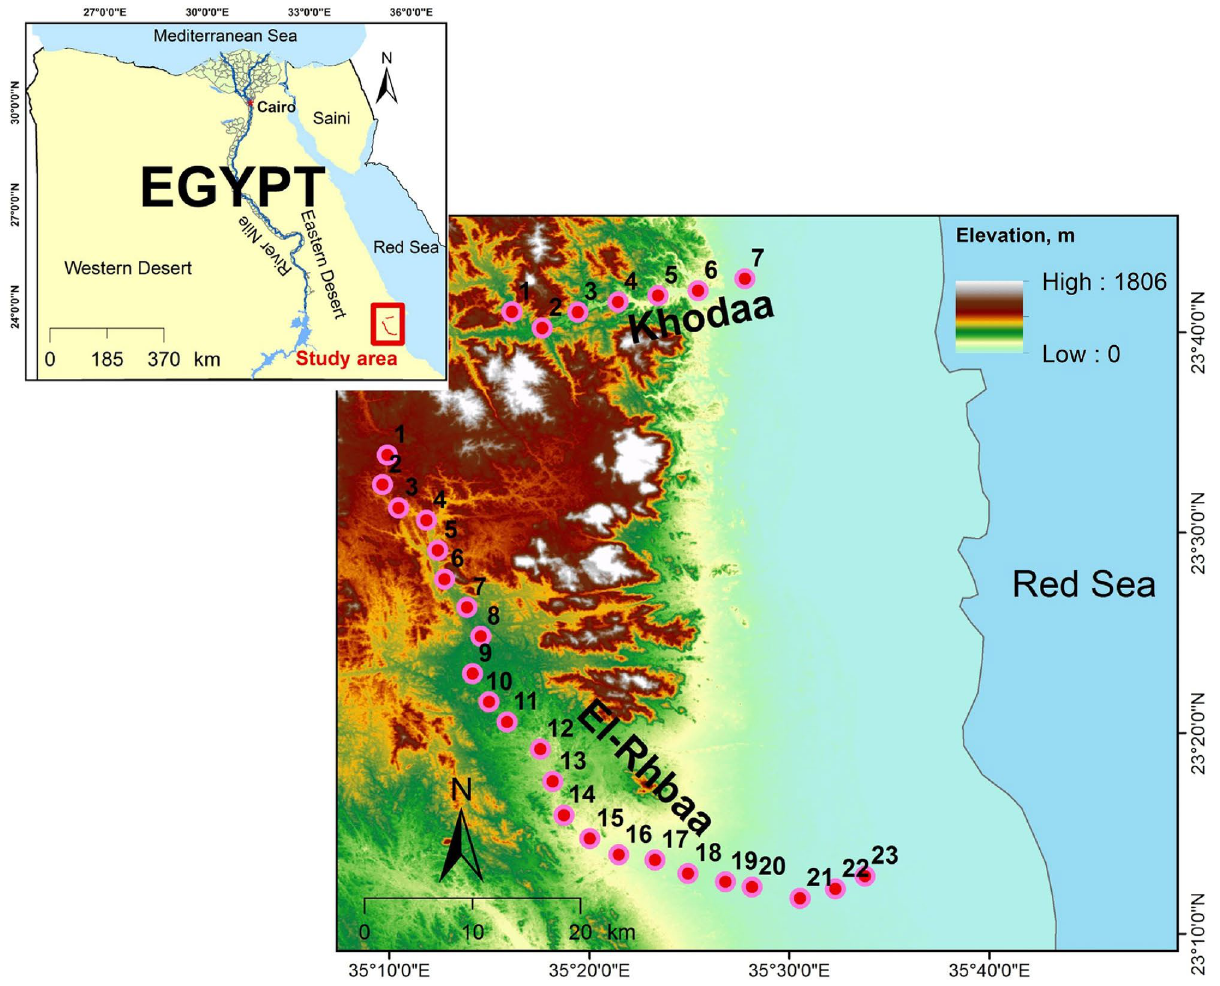
Figure 1. Map of the study region showing the location of the macroplots used to sample the three Vachellia tree taxa. Twenty-three macroplots were analyzed in wadi El Rahaba and seven macroplots were analyzed in wadi Khoda ( n = 7), Gebel Elba National Park, south-eastern Egypt. Macroplots in each wadi are indicated numerically (ArcGIS 10.4.1).